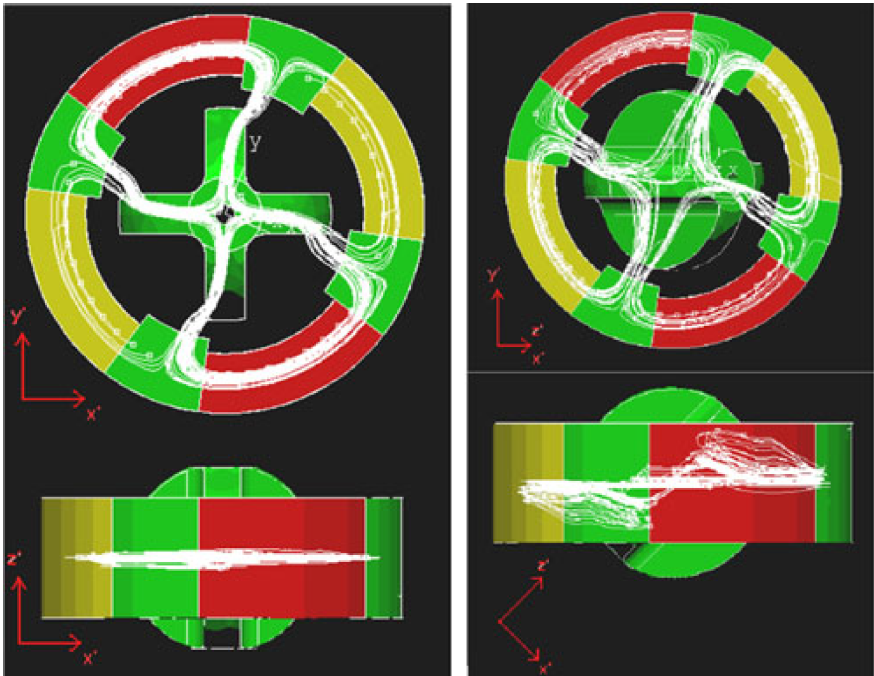
Figure 21. Spherical-RMC rotors simulation, showing magnetic fluxes for two configurations [5]. At the right of Figure 21, top and front view of rotors magnetic fluxes are shown for a reconfigured position, where the driver and driven axes are concurrent with a reconfigura- tion angle non-null, and with a magnetic spring angle θ (cid:54) = 0. In this reconfigured position, it is possible to see magnetic fluxes more dispersed than those of the not-reconfigured one, which indicates a reduction of torque from 230 to 180 mN m (as verified in